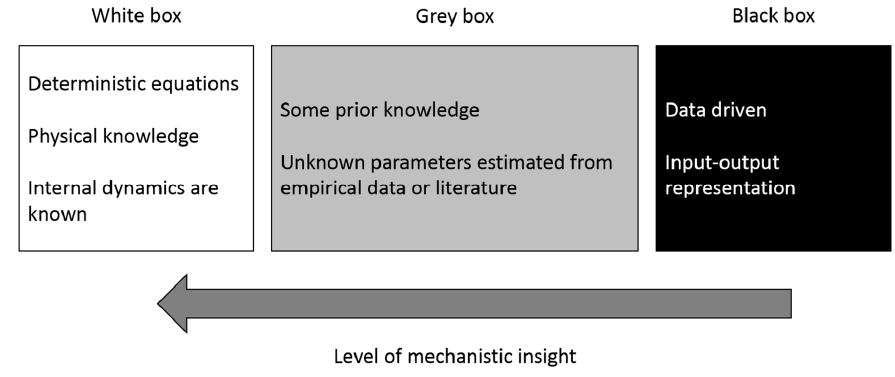
Figure 1. Different types of models.